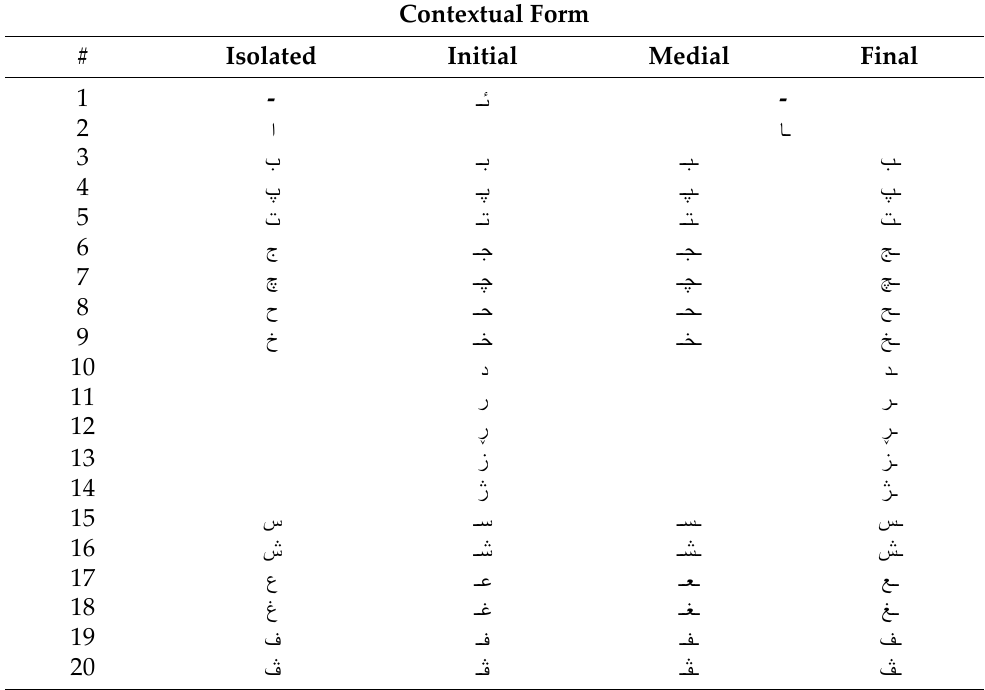
Table 1. Kurdish alphabet forms, both Ligature and